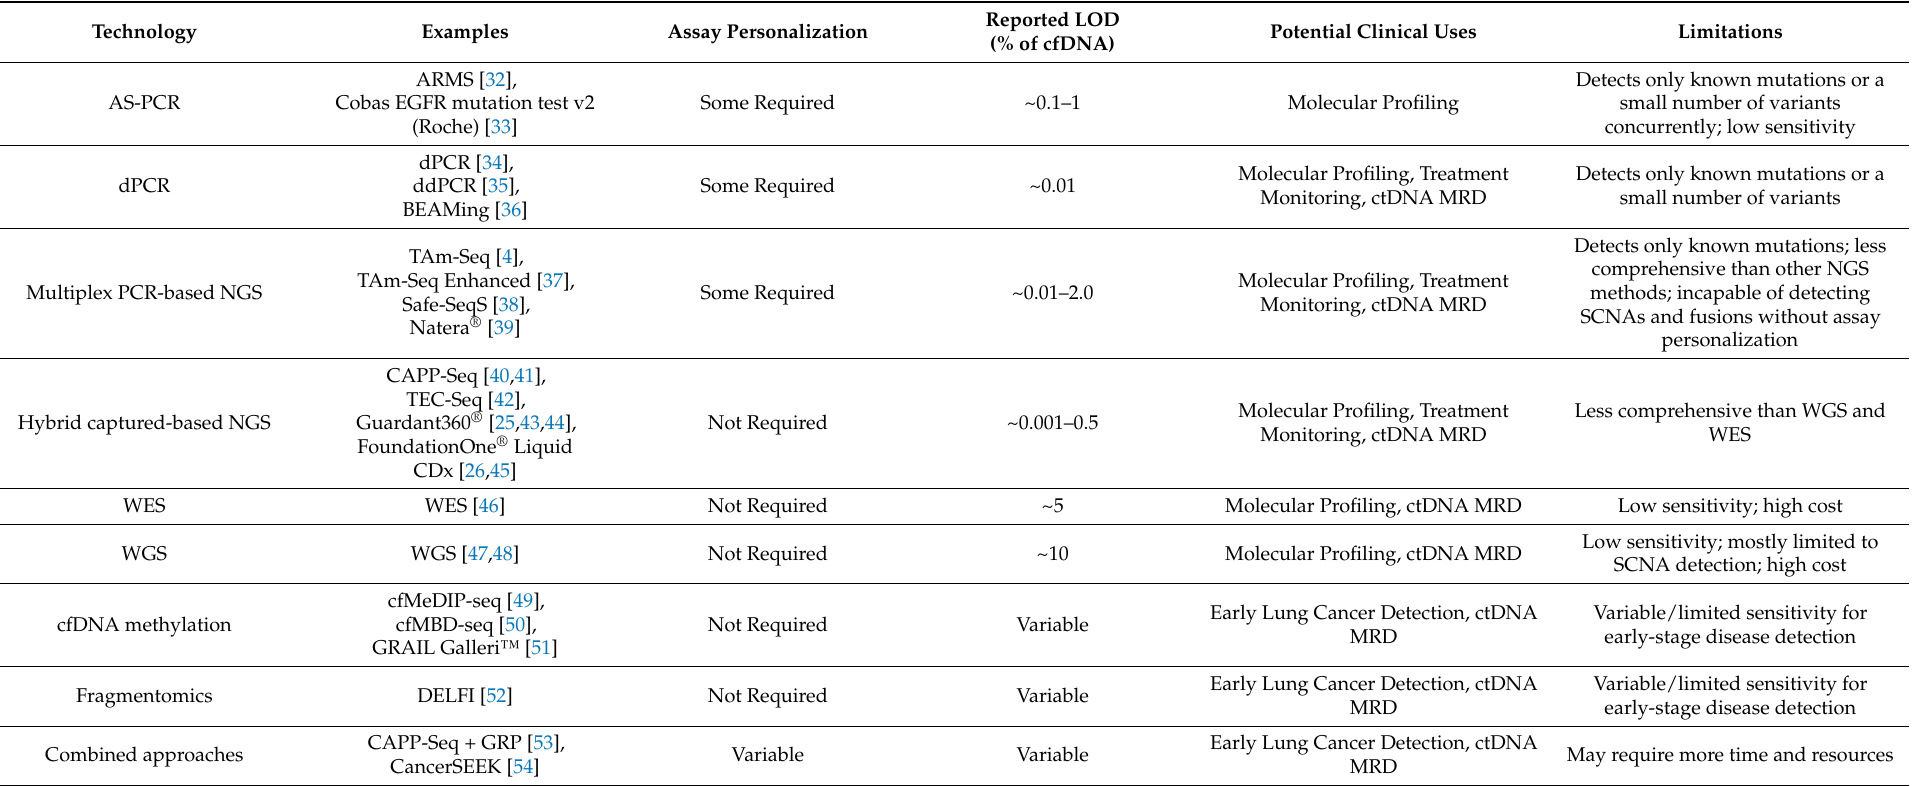
Table 1. ctDNA detection